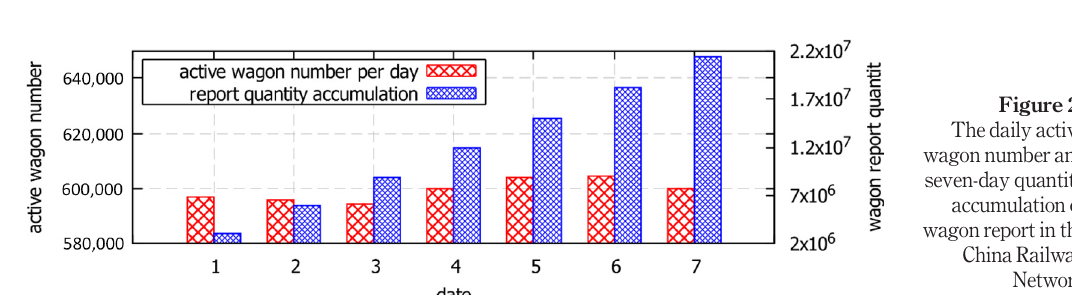
Figure 1. Pingdingshan East-